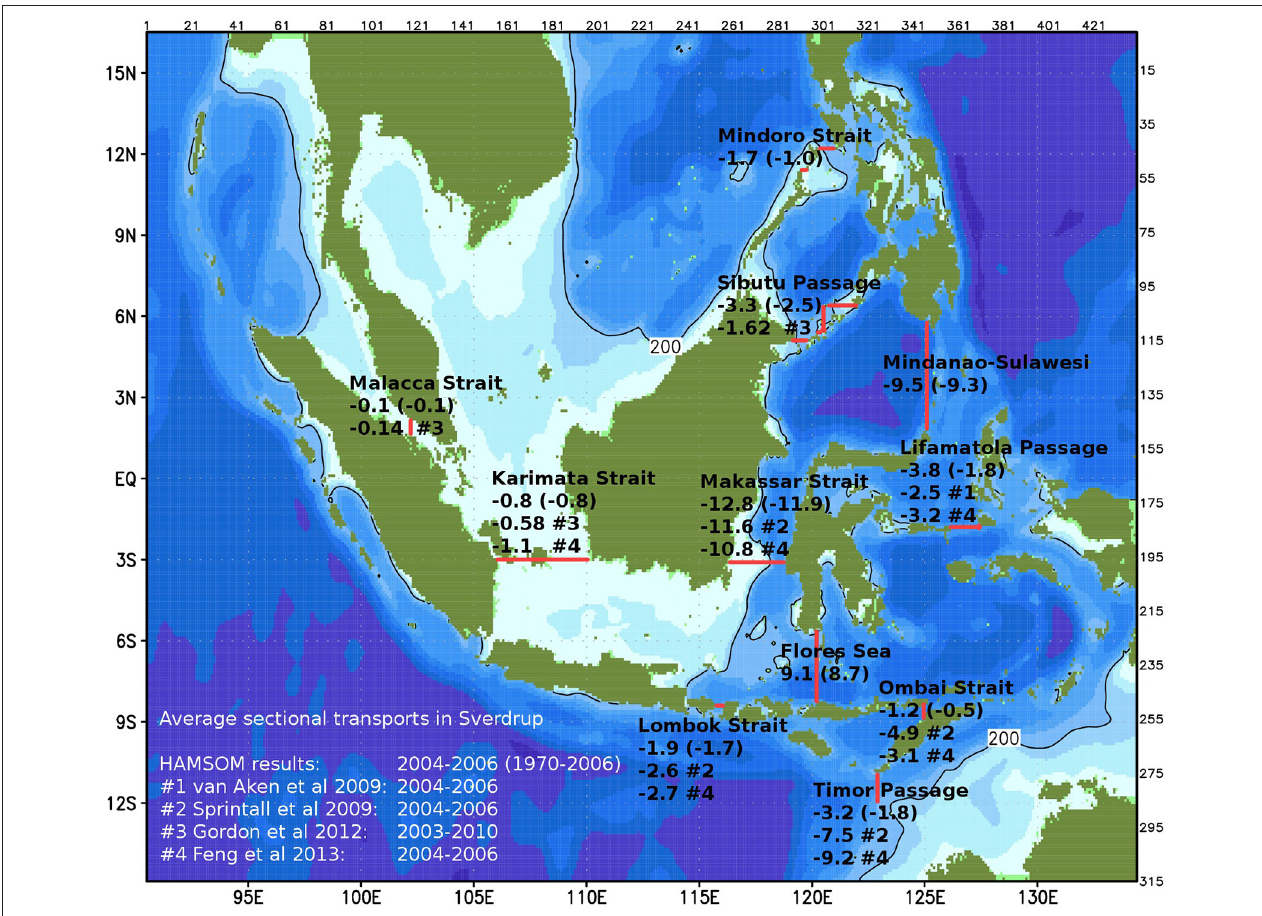
(SST). Both are shown in Figure 4 including a map for different